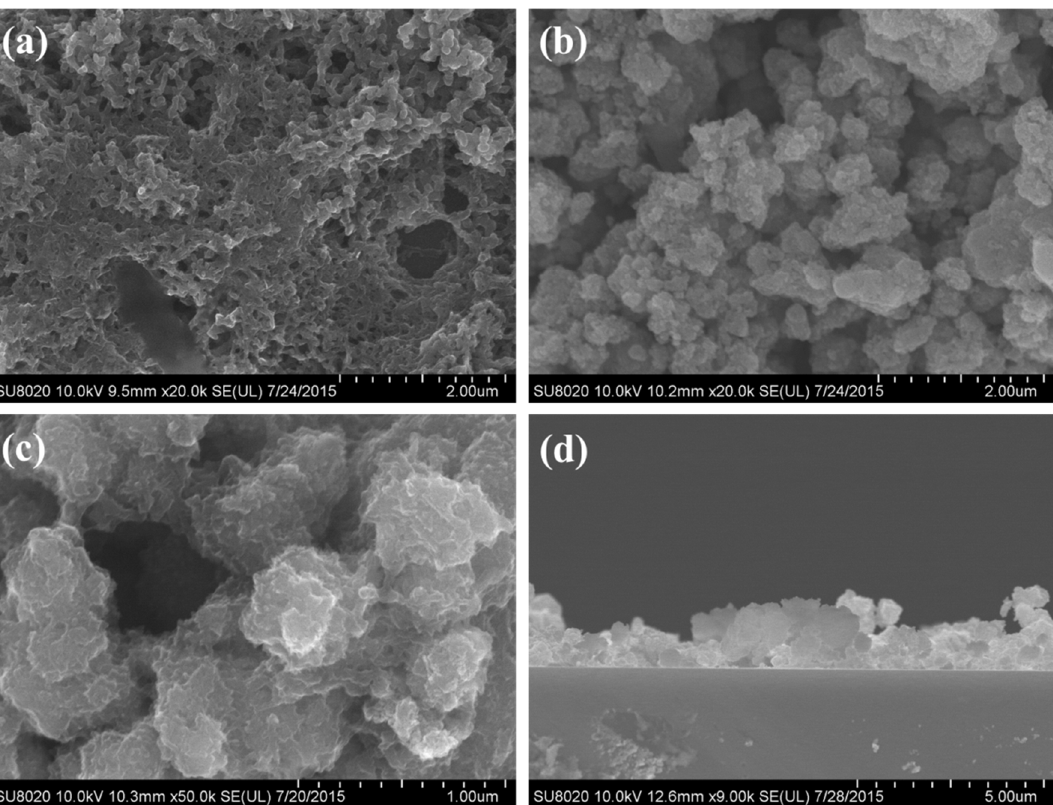
Figure 2. SEM images of ( a ) the pure PANI; ( b ) pure TiO 2 NPs; ( c ) TiO 2 @PANI products at m (TiO 2 )/m (Ani) = 2 and ( d ) cross section of gas sensing thin film prepared by the liquid–gas interfacial self-assembly method at m (TiO 2 )/m (Ani) = 2.